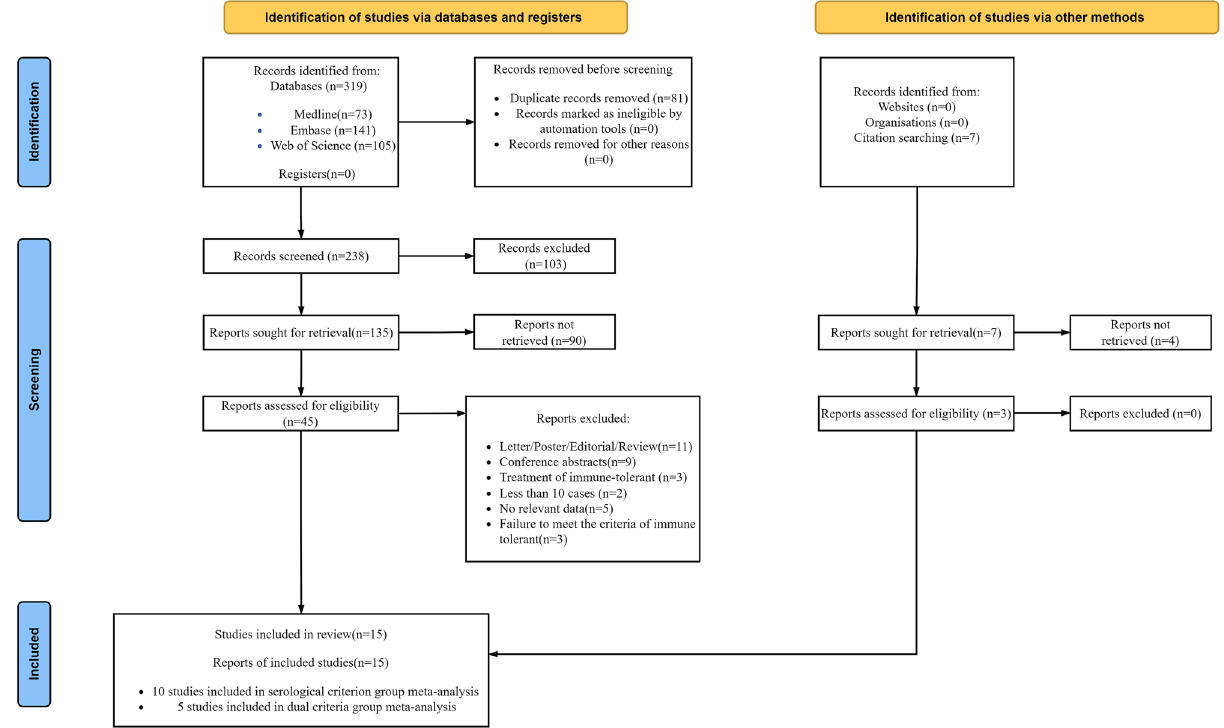
Figure 1. Flow diagram of literature search and study